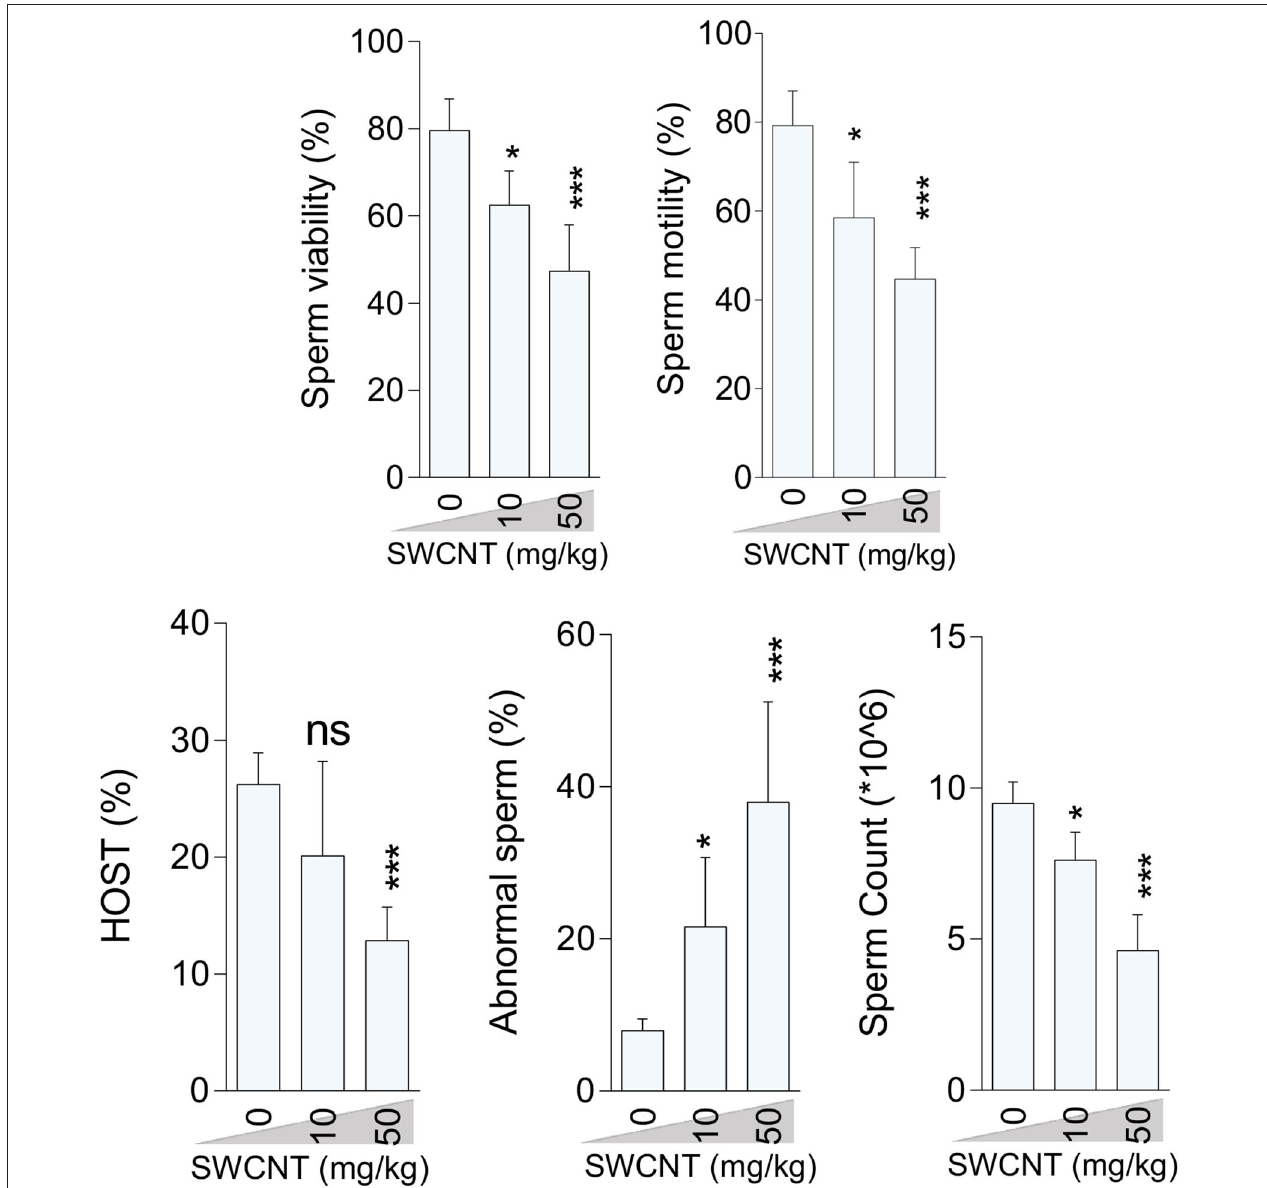
FIGURE 3 | Effect of single-walled carbon nanotubes (SWCNT) on epididymal sperm parameters in mice (mean ± SEM, n = 6). HOST: hypo-osmotic swelling test. Asterisks indicate significantly different from the control (0 ppm) group (* P < 0.05, *** P < 0.001).